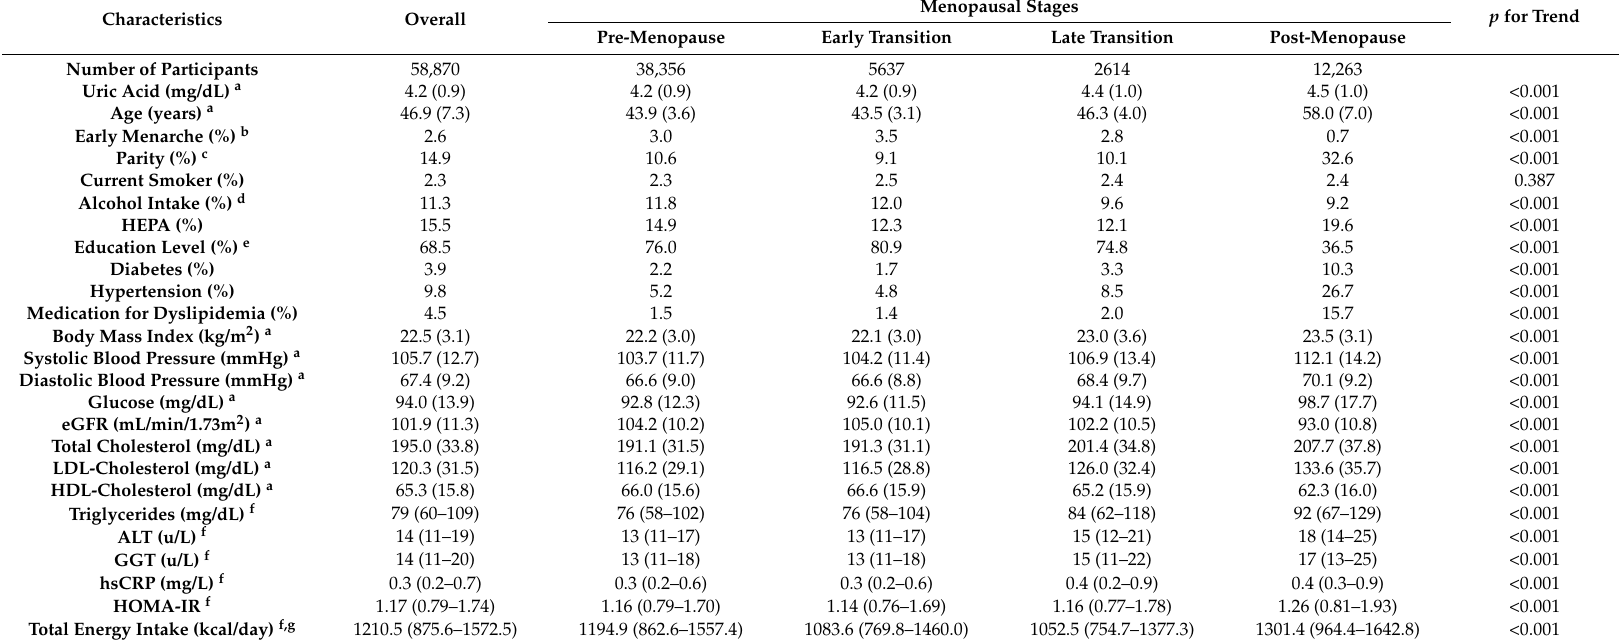
Table 1. Characteristics of study participants across menopausal